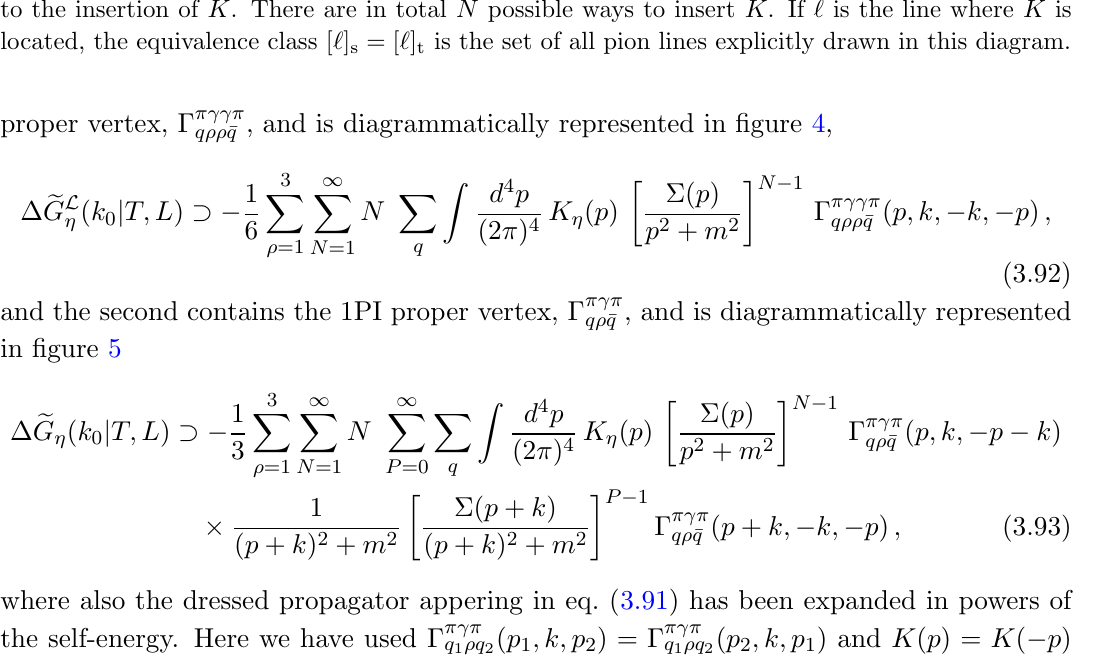
Figure 4 . Diagrammatic representation of eq. (3.92). The number of self-energy insertions is N (cid:0) 1. There are in total N lines in the loop, of which N (cid:0) 1 are standard propagators, and one corresponds to the insertion of K . There are in total N possible ways to insert K . If ‘ is the line where K